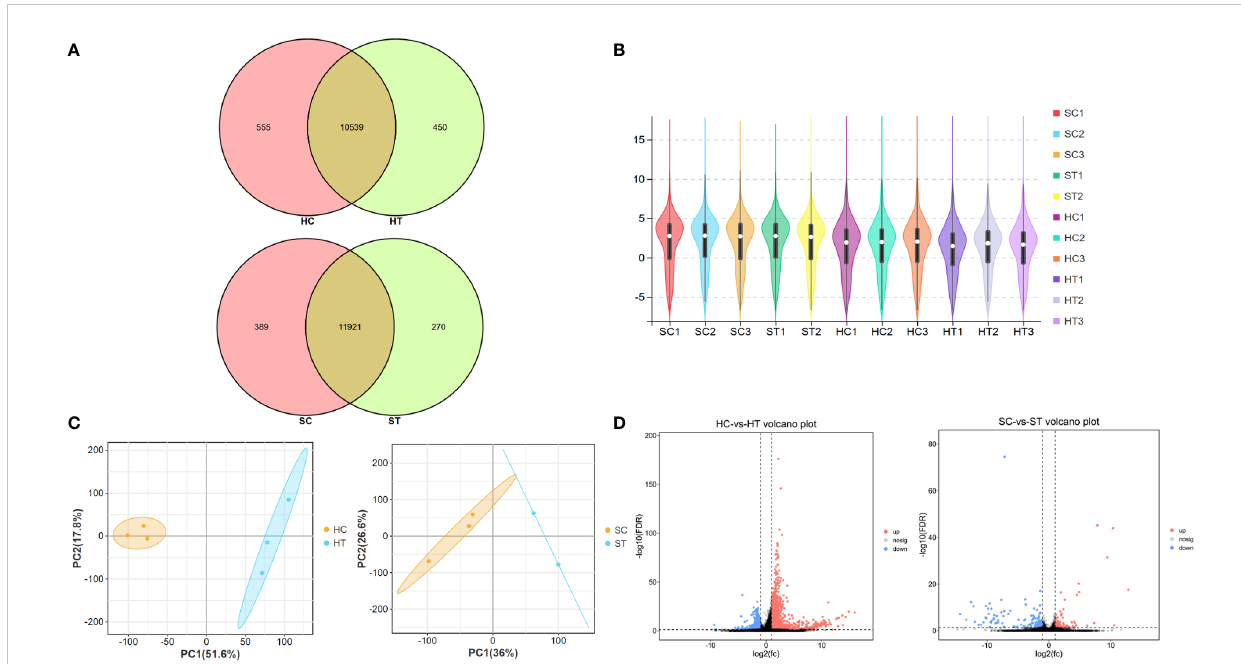
FIGURE 2 Assisted reproductive technology ( ART) - changed gene expression pro fi les in heart and spleen tissues of offspring. (A) Venn diagram shows the number of genes that are co-expressed and speci fi cally expressed between groups; (B) violin plot shows the distribution of gene expression in the sequenced samples; (C) principal content analysis (PCA) result of heart and spleen samples, respectively; (D) volcano plot indicates the differently expressed genes (DEGs) between ART and control groups in heart and spleen, respectively. HC and HT represent the heart tissue of the offspring of the control and ART group, respectively; SC and ST represent the spleen tissue of the offspring of the control group and the ART group,